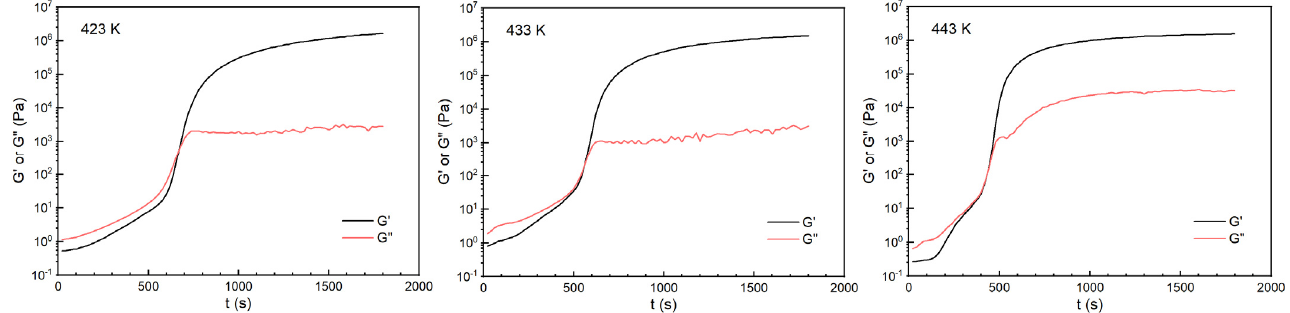
Figure 11. Changes in G’ and G” with time for the H 6 XDI/BES system at different temperatures. The crossover of G’ and G” was regarded as the gel point of the system. The gelation time at different temperatures is listed in Table 3. Table 3. Gelation time at different temperatures for the H 6 XDI/BES system. Temperature